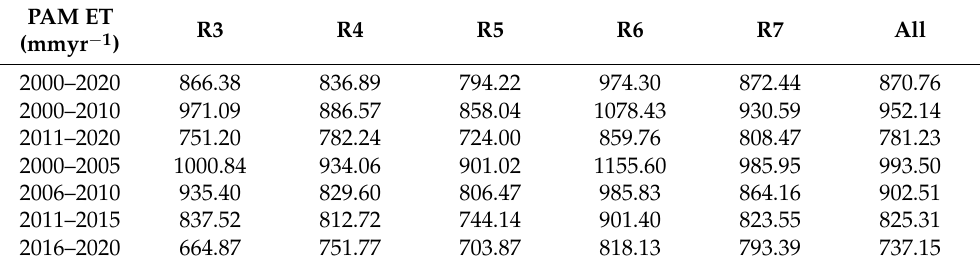
Table 5. The average annual water use, PAM ET (mmyr − 1 ), for seven groups of years from 2000–2020 for five reaches and the weighted average of All reaches along the Lower Colorado River. PAM ET (mmyr − 1 )